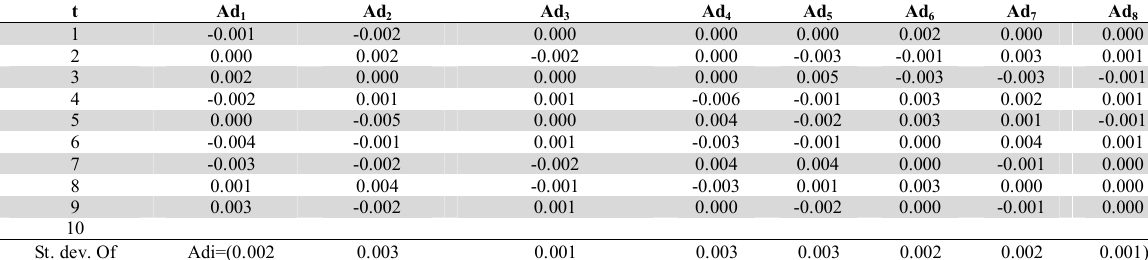
Fitting error values of all IR and standard deviation